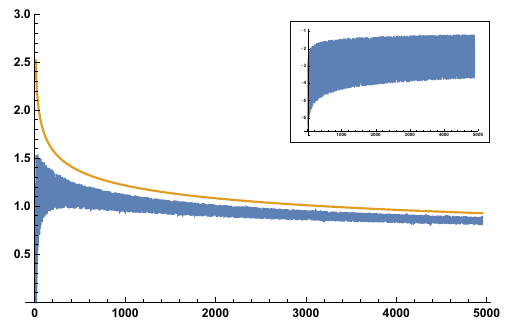
Figure 7 . We plot s Vir ( δ, ∆) (blue) as defined in (1.6) for the non-chiral Monster CFT partition function for δ = ∆ 0 . 4 as a function of ∆. The orange line is given by the predicted universal ∆0 . 4 ∆0 . 4 sinh π √ c − 1 3 sinh π √ c − 1 3 √ ∆ √ ∆ correction log ∆ 0 . 4 to check . In the box we plot s Vir (∆ 0 . 4 , ∆) log − π √ c − 1 3 ∆0 . 4 π √ c − 1 3 ∆0 . 4 √ ∆ √ ∆ (cid:19) (cid:18) that the non-universal difference between the two curves is consistent with